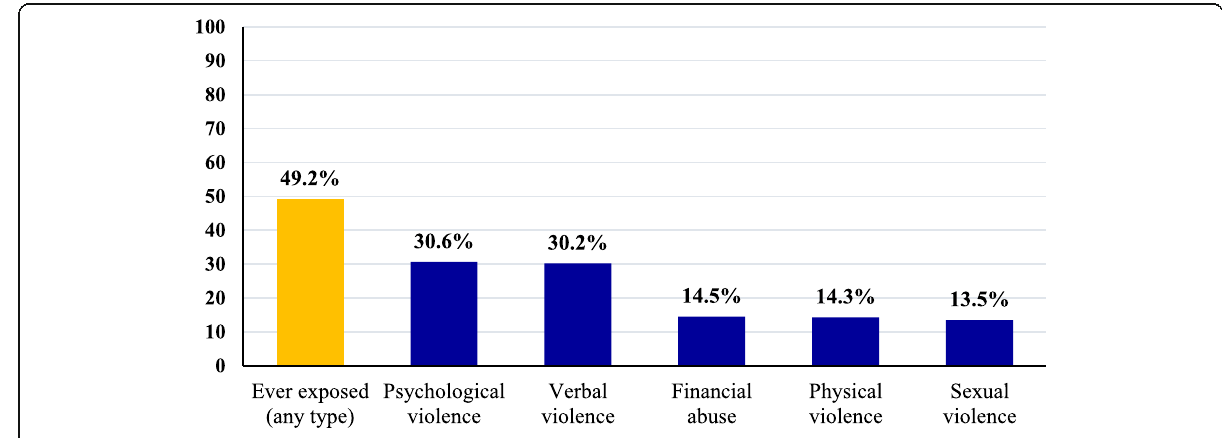
Fig. 1 Distribution of adult Arab women according to the types of IPV they were ever exposed